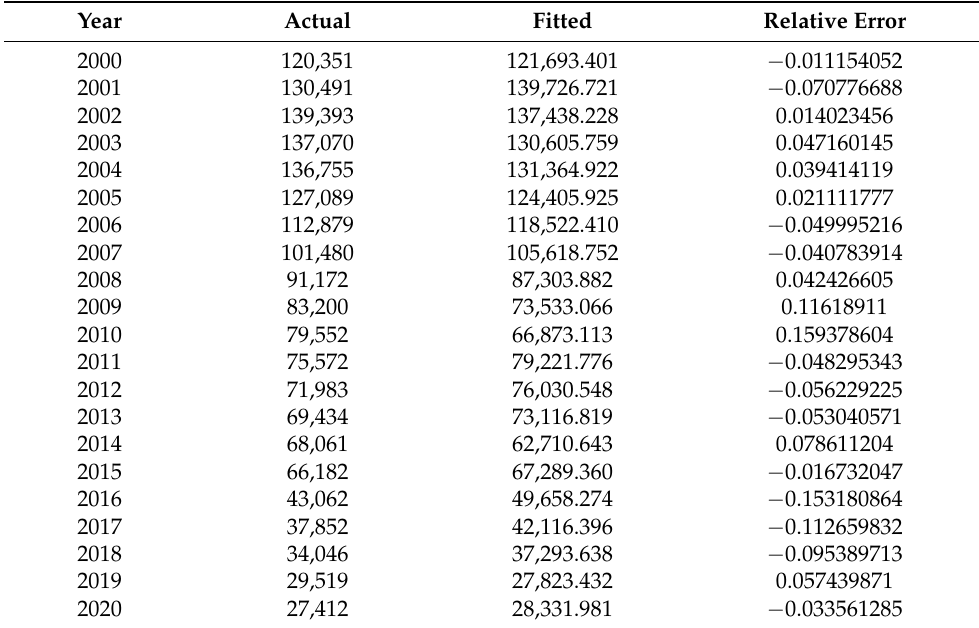
Table 3. Comparison of the fitted and real values for accident-related